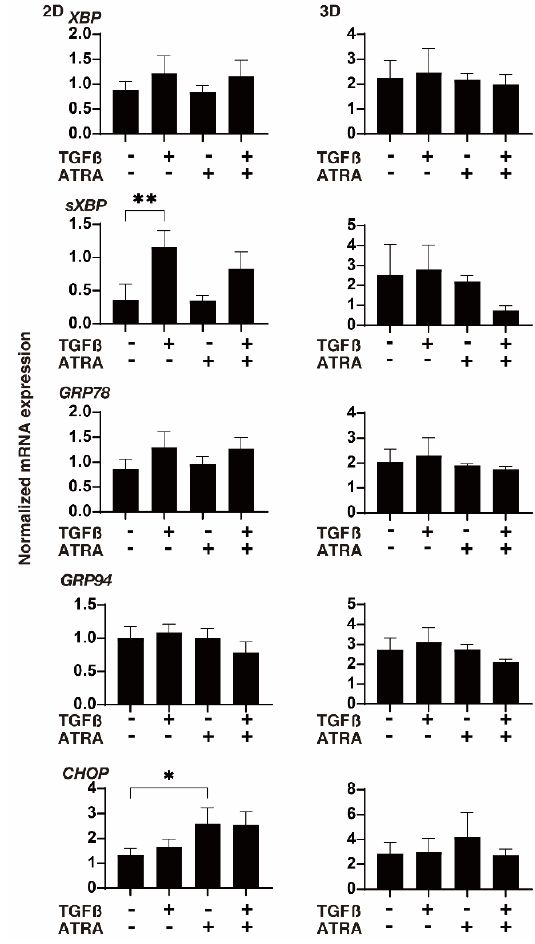
Figure 6. Effects of ATRA on the mRNA expression of TJ-related molecules and major ER-stress- related genes in TGF- β 2-treated 2D- and 3D-cultured HTM cells. Two- and three-dimensionally cultured HTM cells untreated (NT) or treated with 5 ng/mL TGF- β 2 (TGF β ) and/or ATRA (10 µ M) were subjected to qPCR analysis to estimate the expression of mRNA in TJ-related molecules, ZO1 and CLDN11, and major ER-stress-related genes including the X-box binding protein (XBP), sXBP, glucose regulator protein (GRP)78, GRP94, and CCAAT/enhancer-binding protein homologous protein (CHOP). All experiments were performed in triplicate each using freshly prepared 2D HTM cells and 3D HTM spheroids ( n = 15–20, total 45–60) in each experimental condition. Data are presented as the mean ± SEM. * p < 0.05, ** p < 0.01, *** p < 0.005; ANOVA followed by a Tukey’s multiple comparison test.